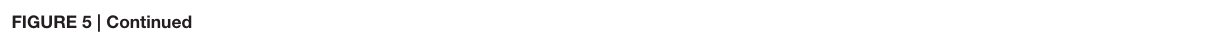
the finding describing how ET responses are important for B. 6 clusters. Cluster #1 ( Figure 6 , in gray), composed of